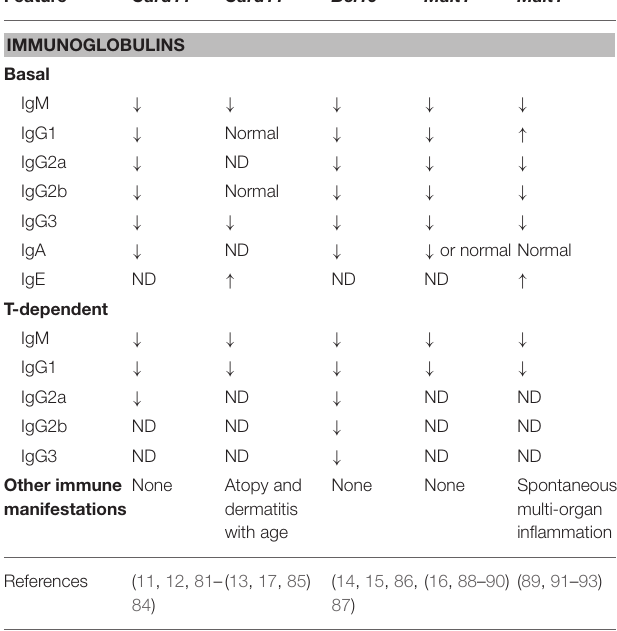
TABLE 1 | Overview of CBM-deficient mouse models. Feature